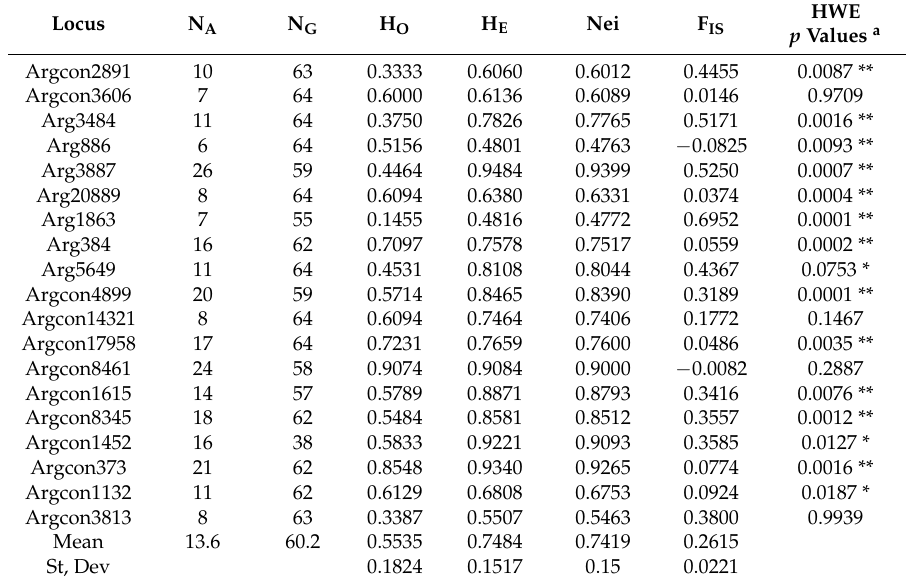
Table 3. Basic statistics of 19 STRs loci developed for Argyresthia conjugella in a survey of 64 individuals from Norway and Sweden.